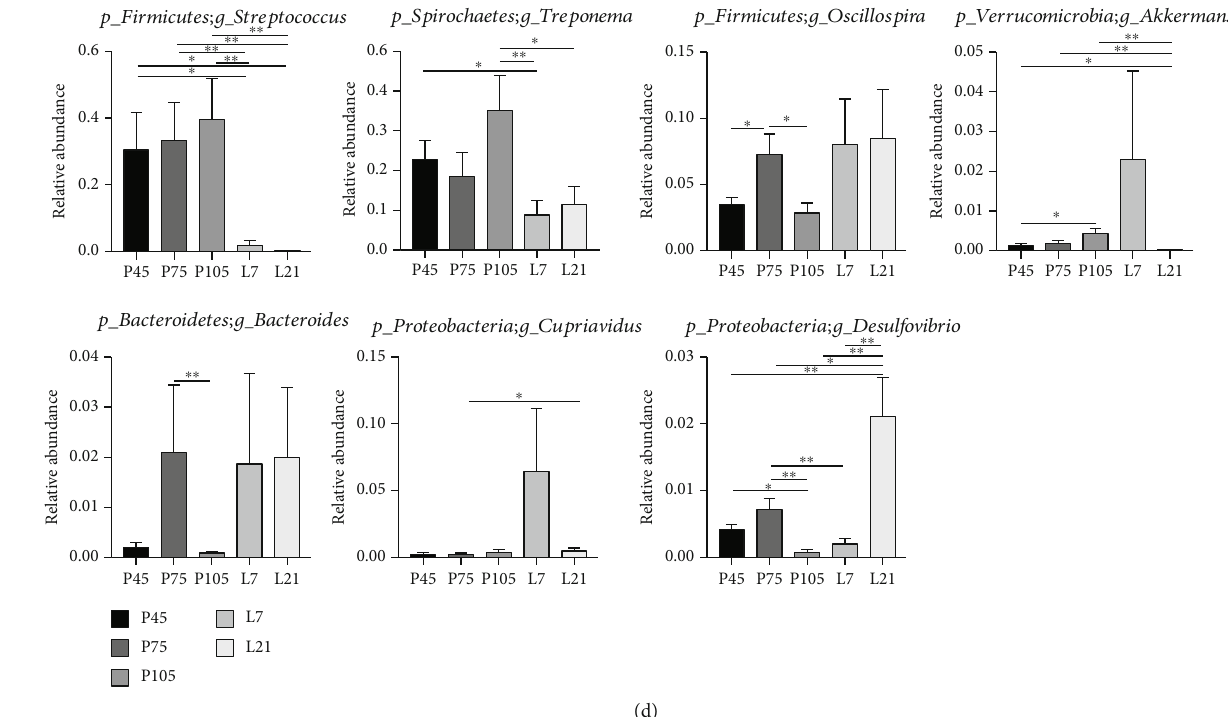
Figure 4: Fecal microbiota community structure of sows at di ff erent stages of pregnancy and lactation. Fecal microbiota distributed at phylum (a) and genera (b) levels. All of the phyla were listed, and only the top twenty genera were listed. Comparison of relative abundances at the phylum (c) and genera (d) levels, and discrepancy of the top ten fecal microbiota was listed. n = 6 ‐ 8 per